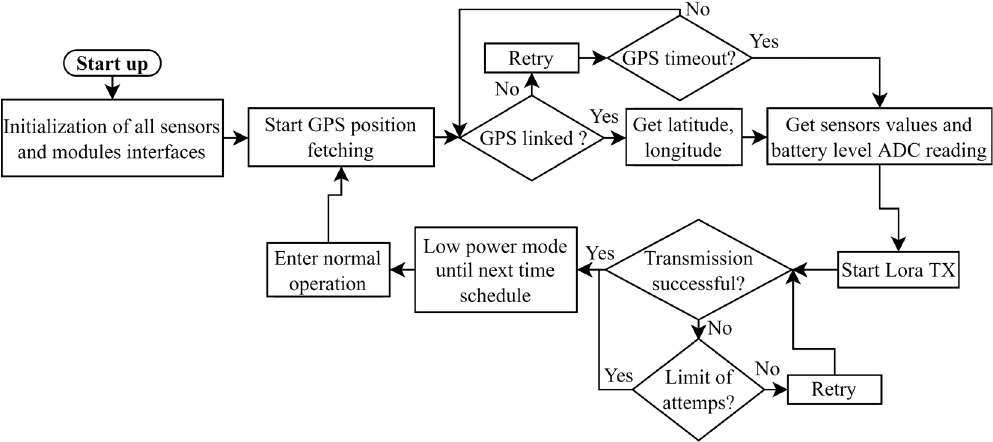
Figure 6. Structural node operation flow diagram.